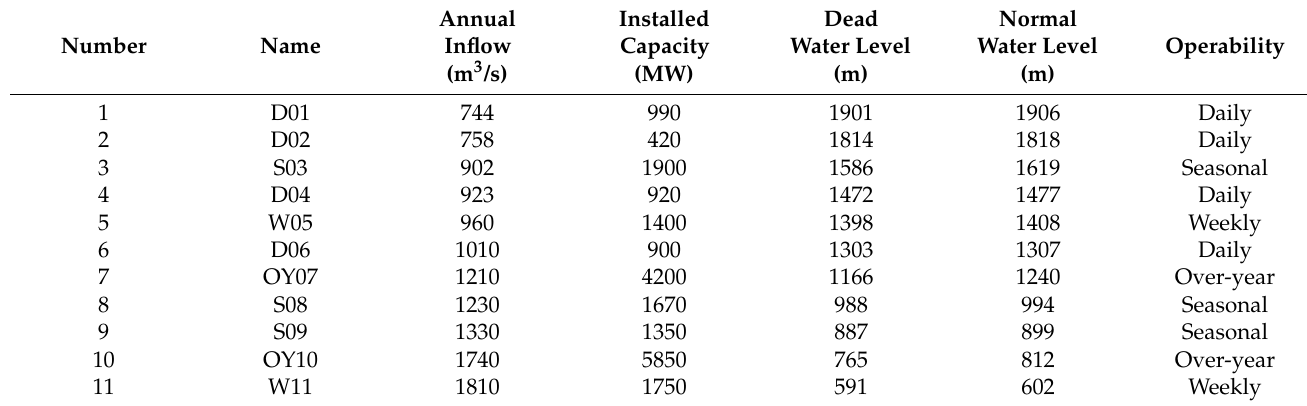
Table 1. Profile of the cascaded reservoirs in the Test River.